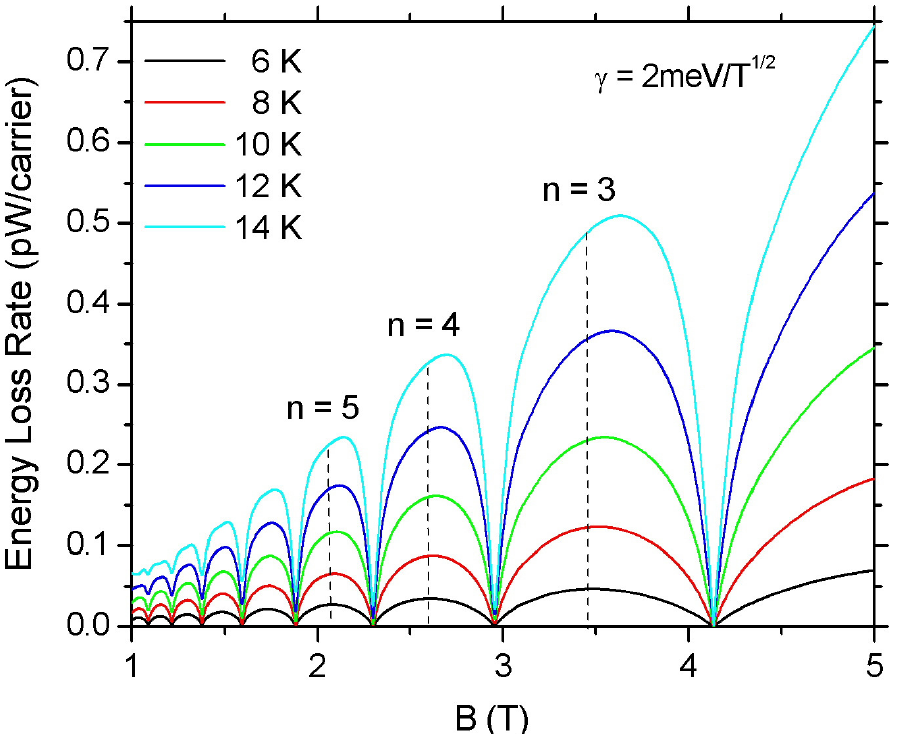
Figure 2. Magnetoscillations of ELR in graphene as a function of the magnetic field for electron temperatures T e = 6,8,10,12 and 14 K. The electron density is n s = 10 16 m − 2 and the LL broadening parameter is taken to be γ = 2 meV/T 1/2 . The positions of the 3rd, 4th, and 5th LL are denoted by the dashed vertical lines.